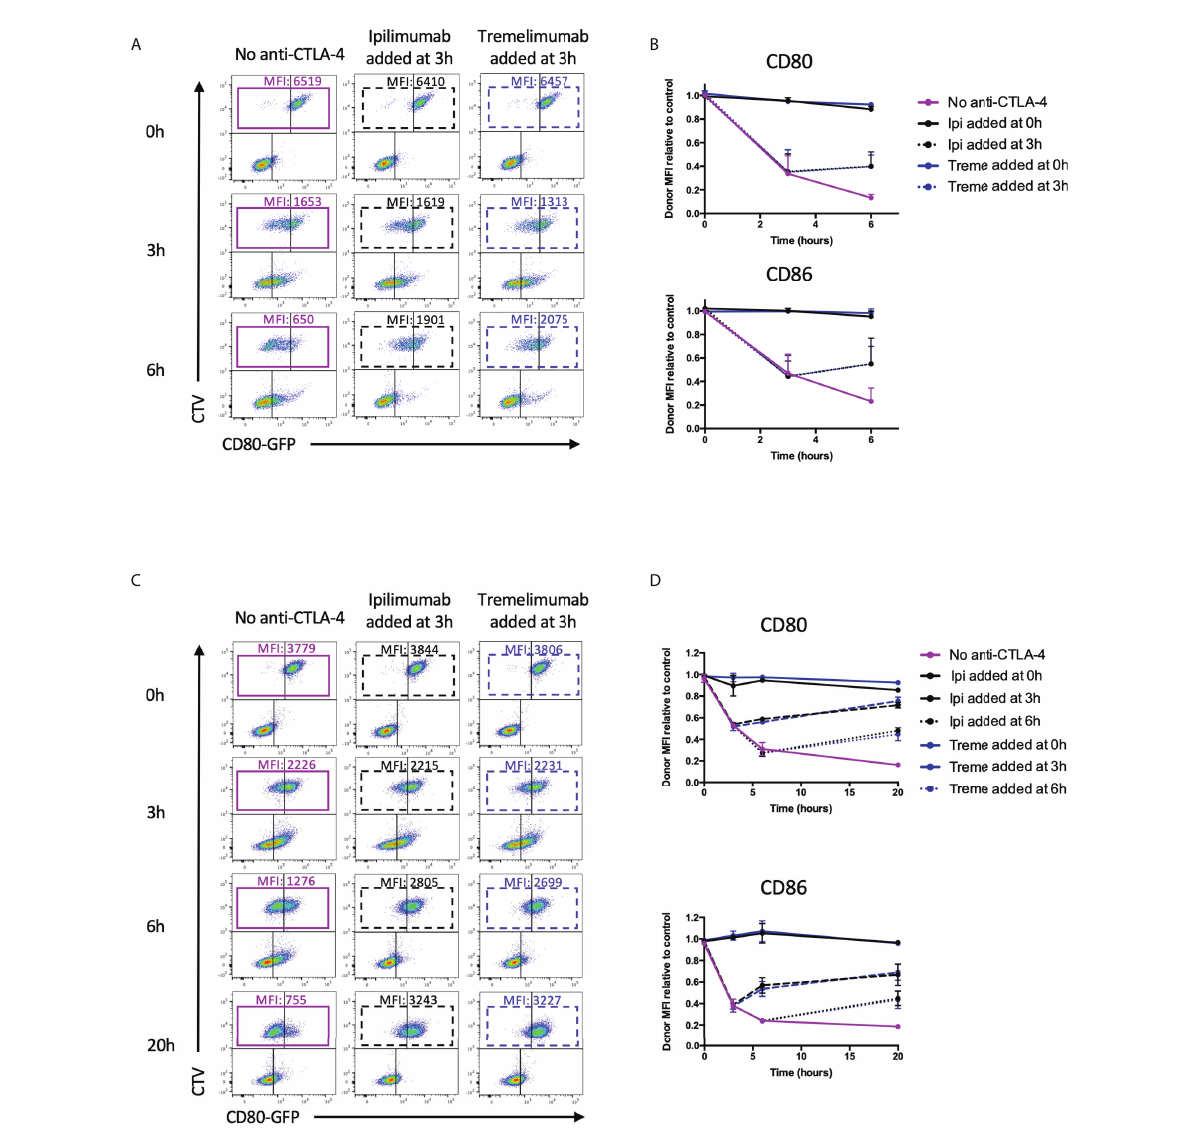
FIGURE 8 Ipilimumab and Tremelimumab interfere with pre-established transendocytosis of CD80 and CD86 to prevent further ligand loss from APC. (A) CTV stained CHO cells expressing either CD80 or CD86-GFP were cultured in the presence of CHO cells expressing CTLA-4 at a 1:1 ratio for 0, 3 or 6 hours at 37°C. Transendocytosis was established for 3 hours in the absence of anti-CTLA-4 Abs at which point soluble ipilimumab (dotted black line) or tremelimumab (dotted blue line) were spiked into culture. Transendocytosis was continued for a further 3 hours to observe the effect of anti-CTLA4 spike. Soluble anti-CTLA-4 antibodies were also added at timepoint 0h to block transendocytosis from the start of the assay (solid black – ipilimumab or blue – tremelimumab lines). Transendocytosis was also performed in the absence of anti-CTLA-4 treatment (Purple line). (B) % of CD80 or CD86-GFP ligand loss from CTV+ CHO cells by transendocytosis was determined by making the GFP MFI CTV+ CHO cells relative to a negative control where CTLA4 was not expressed (n=3). ( C , D ) As in A & B except with CTLA-4 expressing Jurkat and CTV stained DG75 B cells expressing CD80 or CD86-GFP cultured at a Jurkat:DG75 ratio of 2:1. Also an additional spike was performed at